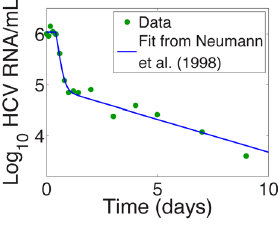
Figure 1. Example of a biphasic decline of HCV, following a short delay, after initiation of interferon- a therapy at t ~ 0 . Fit of Neumann et al. model (solid line) to data for Patient 1E (dots) from [3].